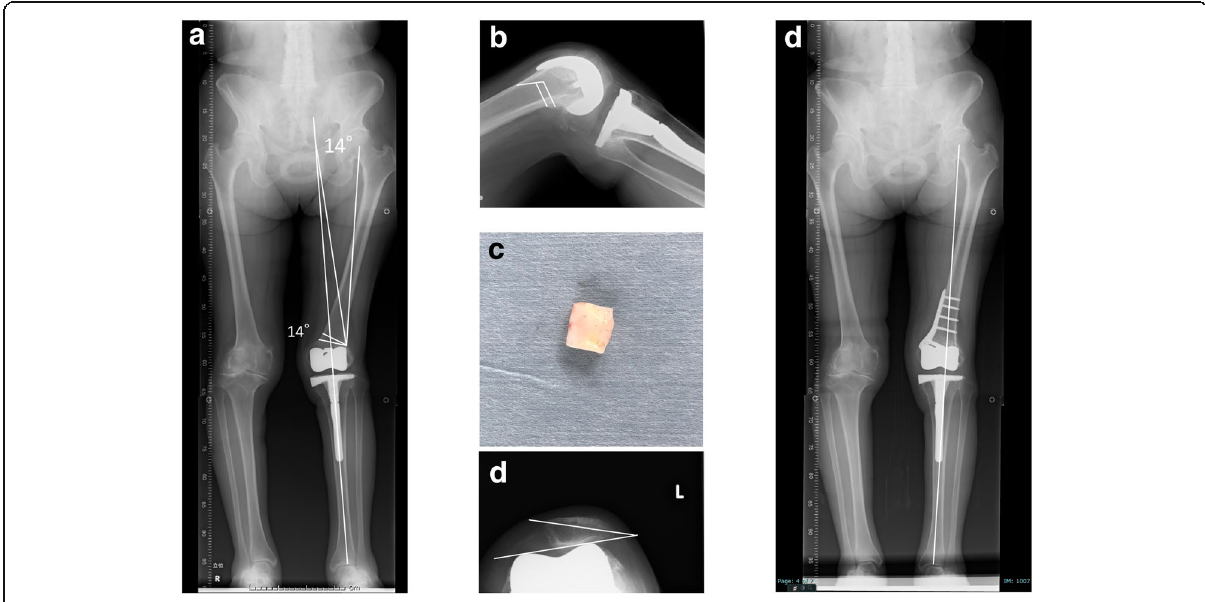
Fig. 4 X-rays after combined CWHTO with medial plication and lateral release. a Preoperative planning using Miniaci method. b Preoperative